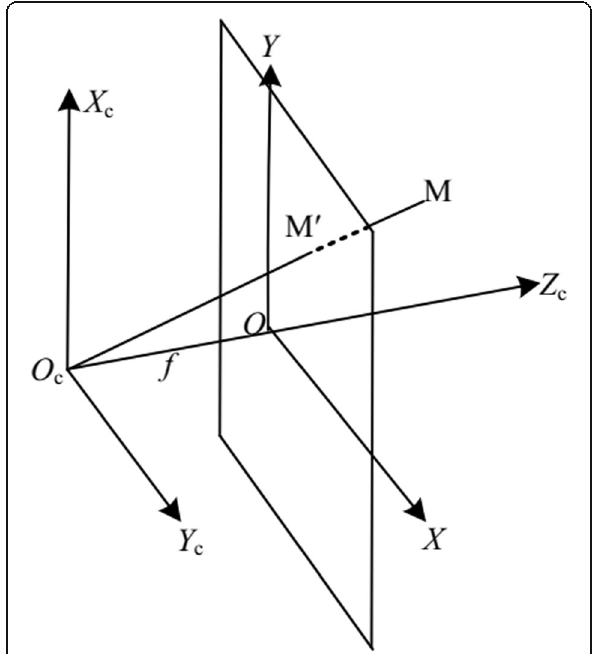
the detection efficiency. In the actual scene, the image captured by the camera on the spot is a color image, so it is necessary to convert the color image into a grayscale image. Each pixel in the color image is composed of three color components of red, green, and blue. The gray level of color image is the process of converting the color values of three components into a certain value ac- cording to a certain correspondence. The mathematical expression is [14]